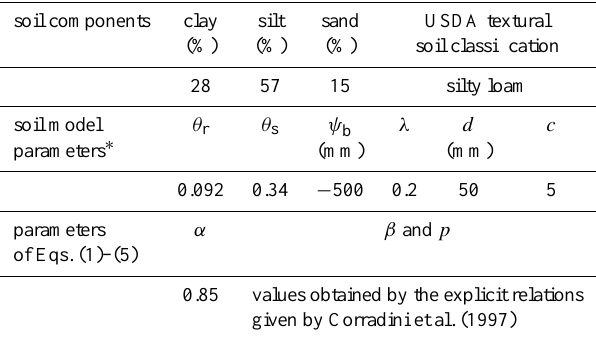
Table 1. Main characteristics of the soil used for the experiments and model parameters. The quantities θ r and θ s denote the volumet- ric water content residual and at saturation, respectively. For other symbols see text. All the quantities are considered invariant from the sealing layer to the parent soil.